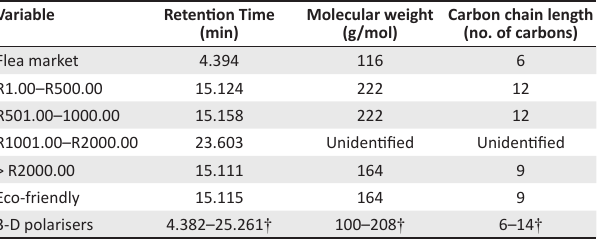
TABLE 4: Properties of organic compounds identified with gas chromatography- mass spectrometry. Variable Retention Time